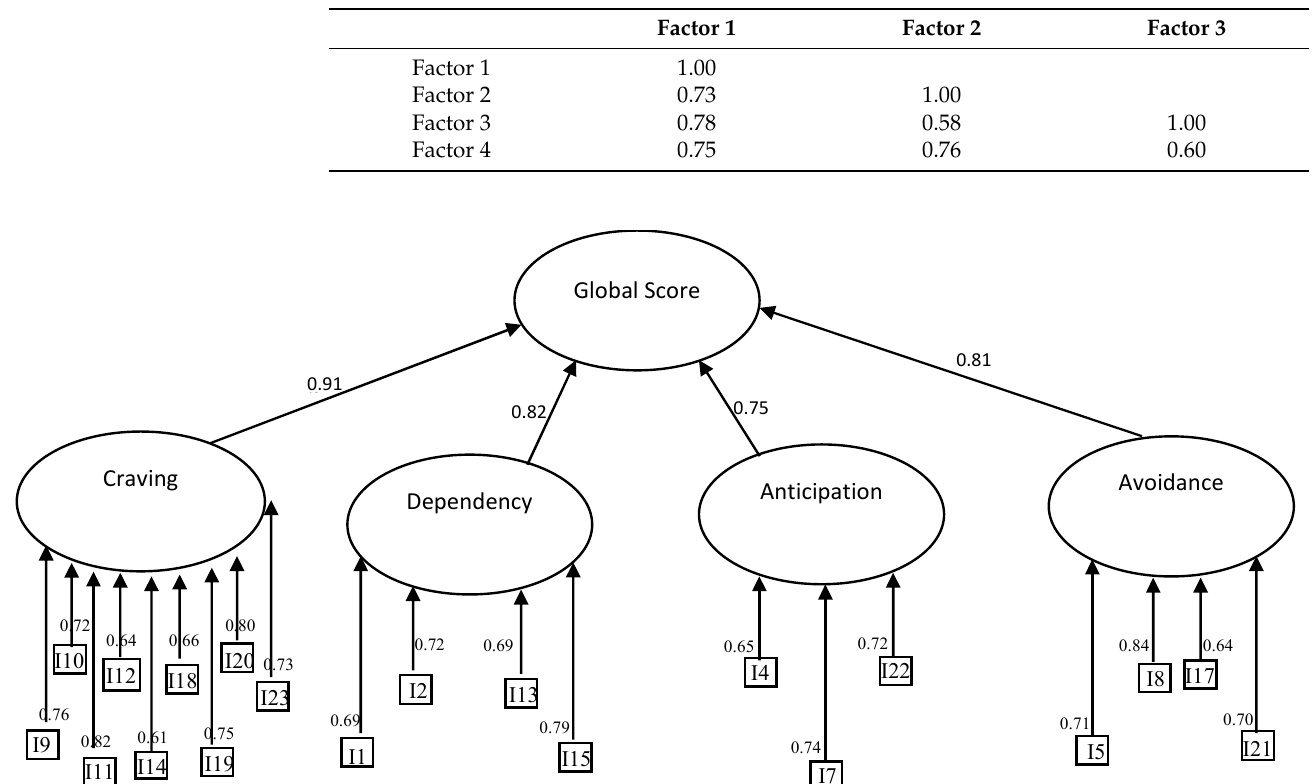
Figure 2. Second-order model for the BWAQ. The figure shows the four-factor model and the second-order factor in the confirmatory factor analysis. Rectangles indicate observed variables (items); ovals represent factors and the second-order model. All factors loading (standardized) are reported and are statistically significant ( p < 0.01). Error terms are not presented for a simpler presentation.